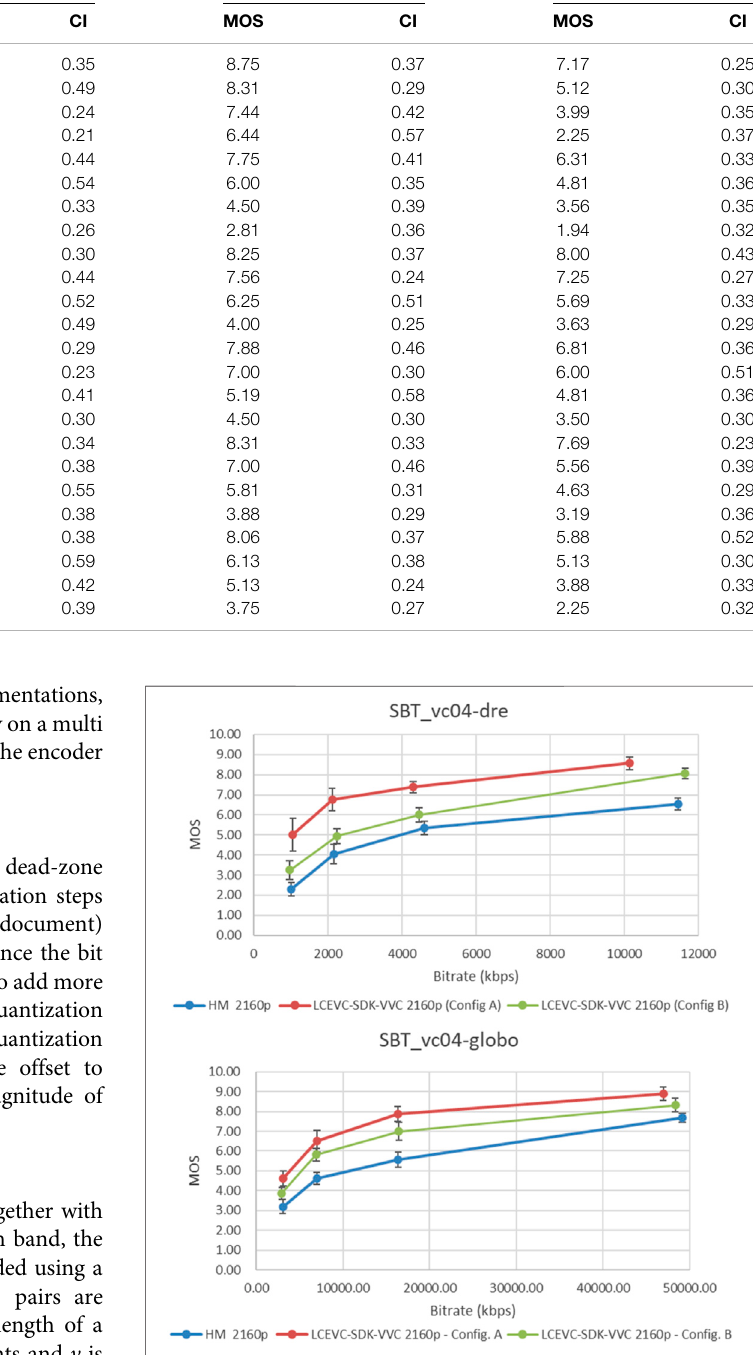
FIGURE6| Rate distortion charts (MOS scorewith con fi dence intervals) for SBT_vc04-dre and